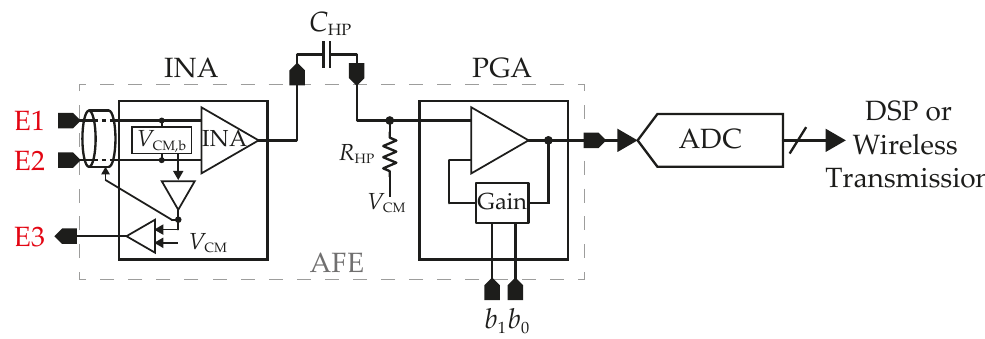
Figure 2. Block diagram of the proposed